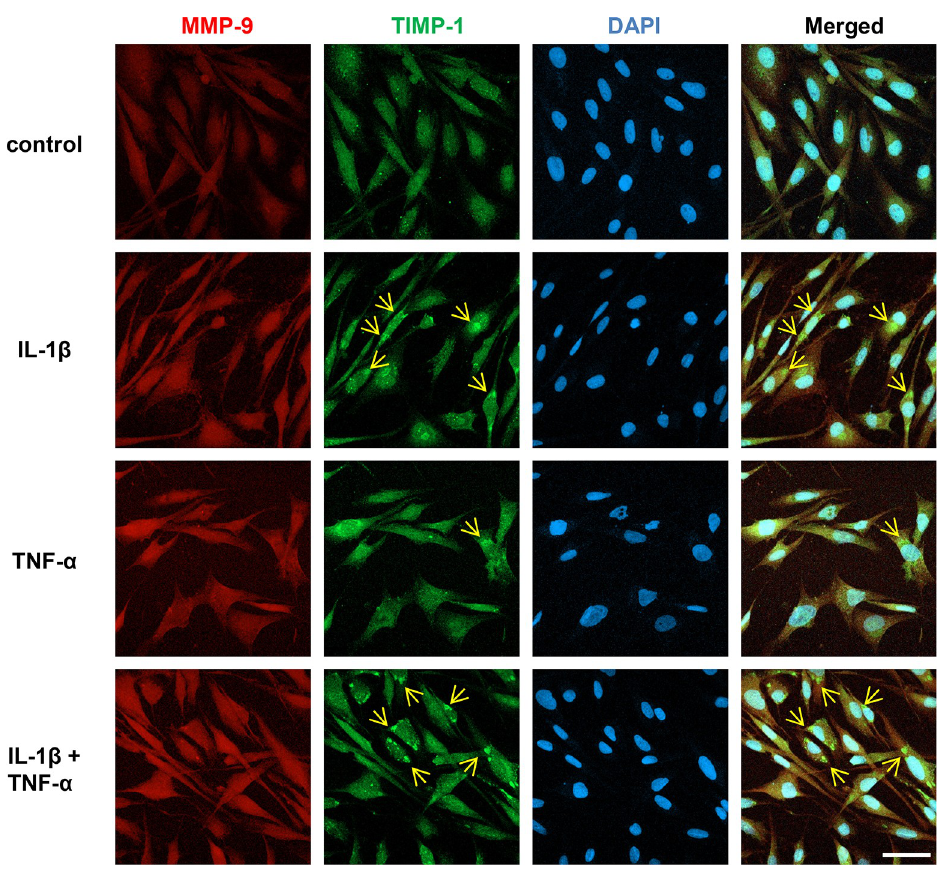
Fig 3. Effect of cytokine treatment on the intracellular MMP-9 and TIMP-1 distribution. MIO-M1 cells were treated or untreated with IL-1 β and/or TNF- α , each at 10 ng/mL in FBS-free media, alone or in combination, for 24 h, and then IHC confocal microscopy was performed to detect intracellular MMP-9 (red) and TIMP-1 (green) by dual- IHC staining using their specific primary and secondary fluorescent antibodies. Nuclear region is defined by chromatin staining with DAPI (blue). Representative micrographs of each treatment group are presented. Arrows point to immunoreactiveTIMP-1 aggregates. Scale bars, 50 μ m. micrograms from the 0 μ M and 300 μ M-treated cells are presented. No detectable changes are seen between treated and untreated cells in the expression pattern of MMP-9 or TIMP-1. Interestingly, however, some cells in the treated samples contain bigger nuclei with increased TIMP-1 speckle numbers (indicated by arrows in enlarged micrograms). Representative images of the nuclei at different concentrations of H O are presented in S4C Fig, and the 2 2 nuclear sizes in treatment groups were measured using Image J software (Fig 4E). The sizes are increased by 5% (not significant, p > 0.05), 35% (p < 0.001), and 62% (p < 0.0001), by 100 μ M, 300 μ M, and 600 μ M treatments, respectively, compared with untreated control. The nuclear size increase shows a dose-dependency, with p < 0.001 (100 μ M vs. 300 μ M) and p < 0.01 (300 μ M vs. 600 μ M). These results suggest that oxidative stress leads to the formation and accu- mulation of nuclear TIMP-1 speckles in MIO-M1 cells. Next, we tested if the oxidative stress condition affects cellular morphologies with IHC with an antibody against β -actin, a major component of cell cytoskeleton (Fig 4F). Untreated cells appear with cobble-shape morpholo- gies, whereas the treated ones develop spindle shapes, suggesting H O induces cell morpho- 2 2 logical changes.